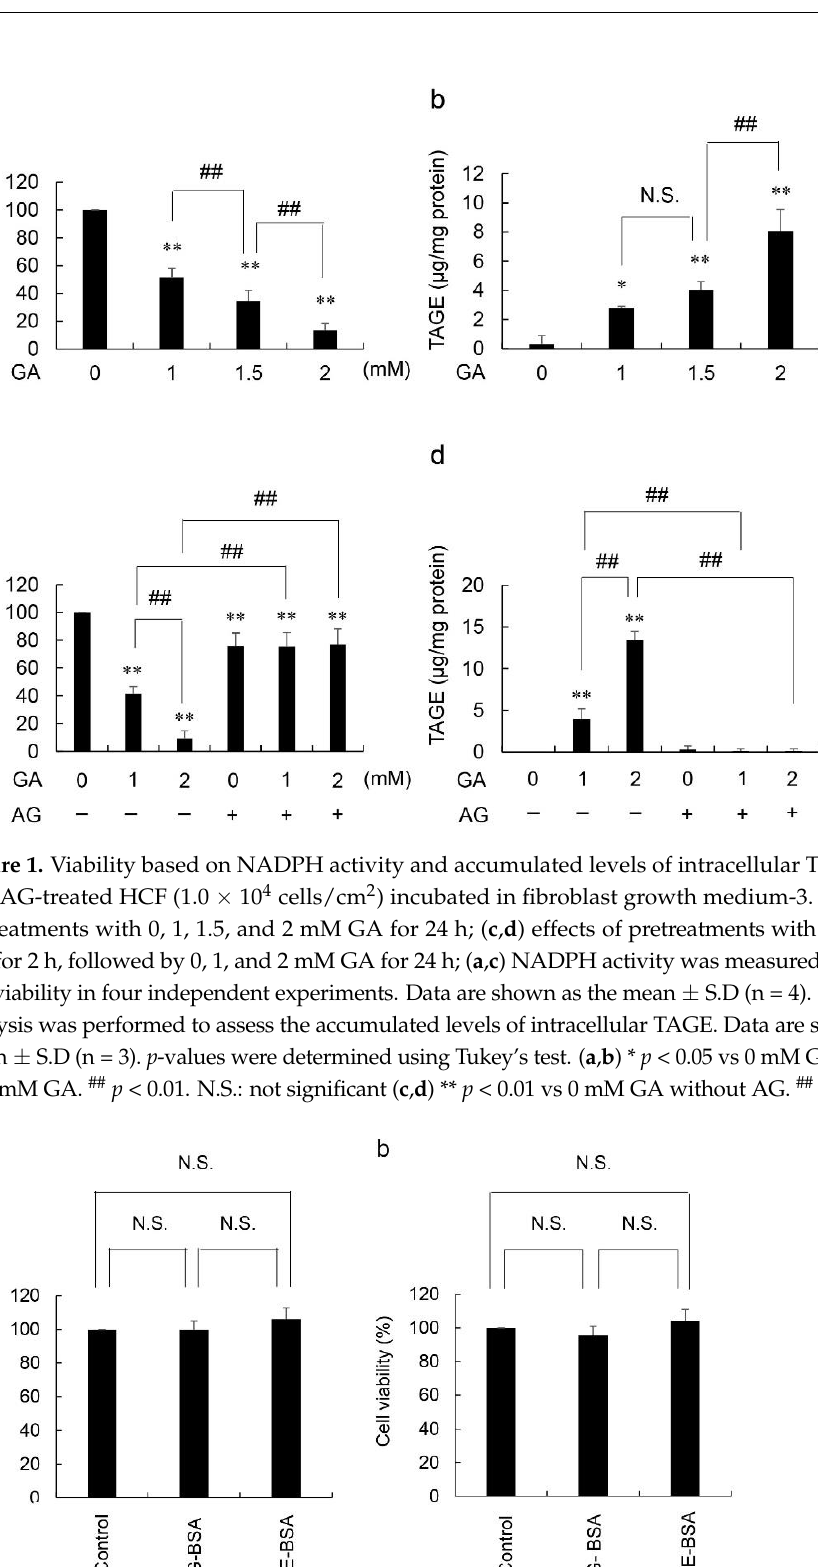
Figure 2. Effects of TAGE-BSA on HCF were evaluated using the NADPH activity assay with the WST-8 method. Control: PBS ( − ). HCF (1.0 × 10 4 cells/cm 2 ) were incubated in fibroblast growth WST-8 method. Control: PBS (‒) . HCF (1.0×10 4 cells/cm 2 ) were incubated in fibroblast growth me- medium-3. Data are shown as the mean ± S.D (n = 3). P-values were based on Tukey’s test. N.S.: not dium-3. Data are shown as the mean ± S.D (n = 3). P- values were based on Tukey’s test. N.S.: not significant. ( a ) HCF was treated with 100 µ g/mL NG-BSA and TAGE-BSA for 24 h. ( b ) HCF was significant. ( a ) HCF was treated with 100 μg/mL NG -BSA and TAGE-BSA for 24 h. ( b ) HCF was treated with 200 µ g/mL NG-BSA and TAGE-BSA for 24 treated with 200 μg/mL NG -BSA and TAGE-BSA for 24 h.